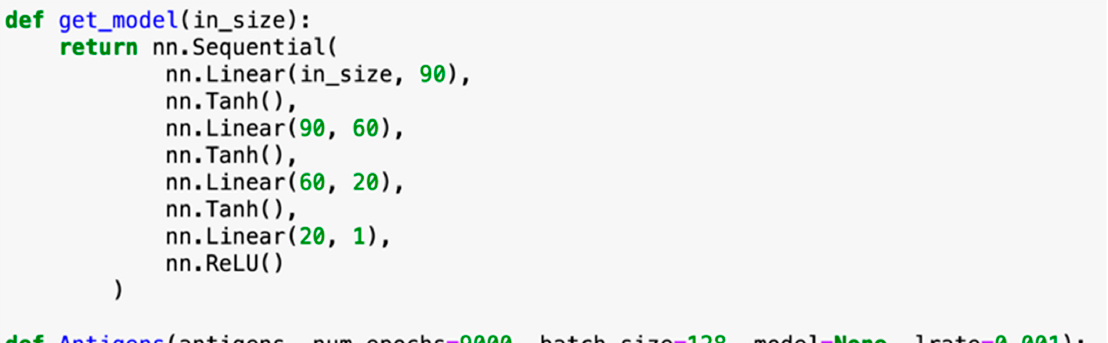
Figure 3. Learning rate adjustment code based on DeepVacPred parameters. Reprinted/adapted with permission from Ref. [7]. 2021, Yang, Z., Bogdan, P., & Nazarian, S. [7] (Supplementary File S10).